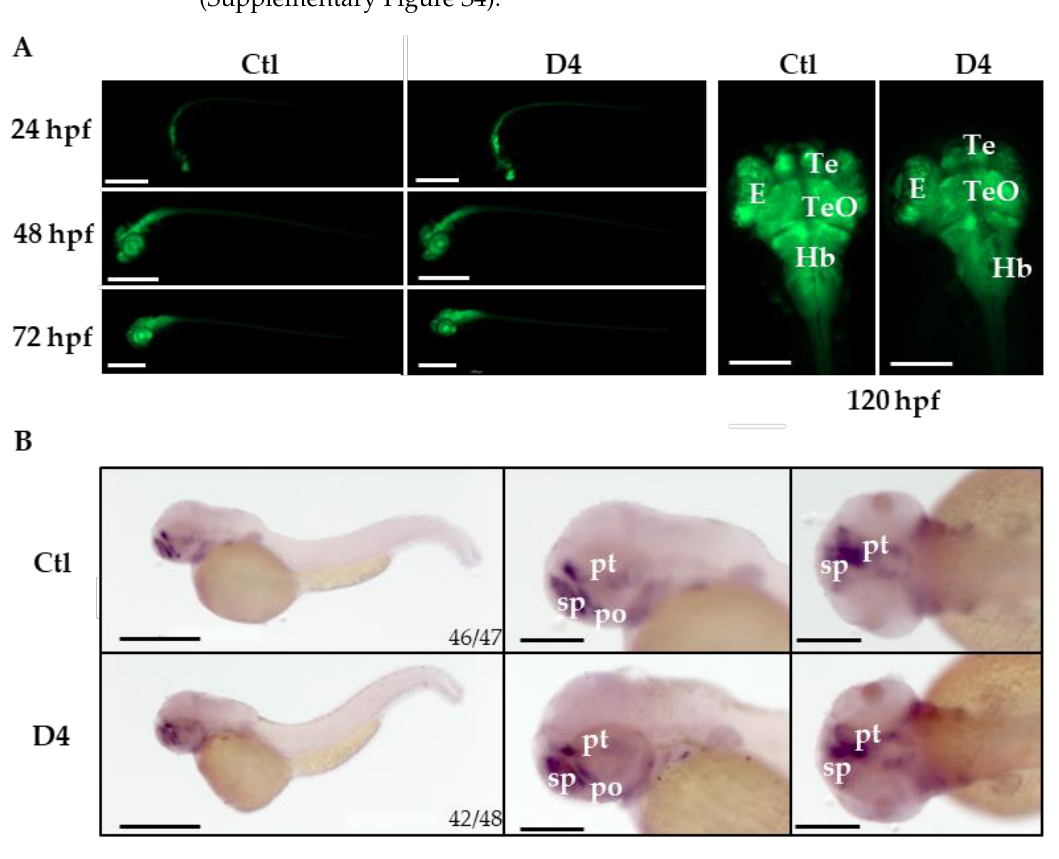
Figure 4. Neuronal characterization of control and mutant embryos . ( A ) Representative images of control and mutant Tg( neurod1 :EGFP) embryos at different stages of development. Size bar = 500 and 200 µ m. The analysis was performed in 3 experiments, and more than 100 embryos were analyzed in total per group. ( B ) Whole-mount in situ hybridization for dlx2a performed in embryos at 48 hpf. The experiment was performed twice. The numbers at the bottom of the images indicate the ratio between embryos with the observed phenotype and the total number of stained embryos. Size bar = 500 and 200 µ m. E, eye; Hb, hindbrain; Ob, olfactory bulb; Te, telencephalon; TeO, tectum opticum; pt, prethalamus; po, preoptic area; sp, subpallium.